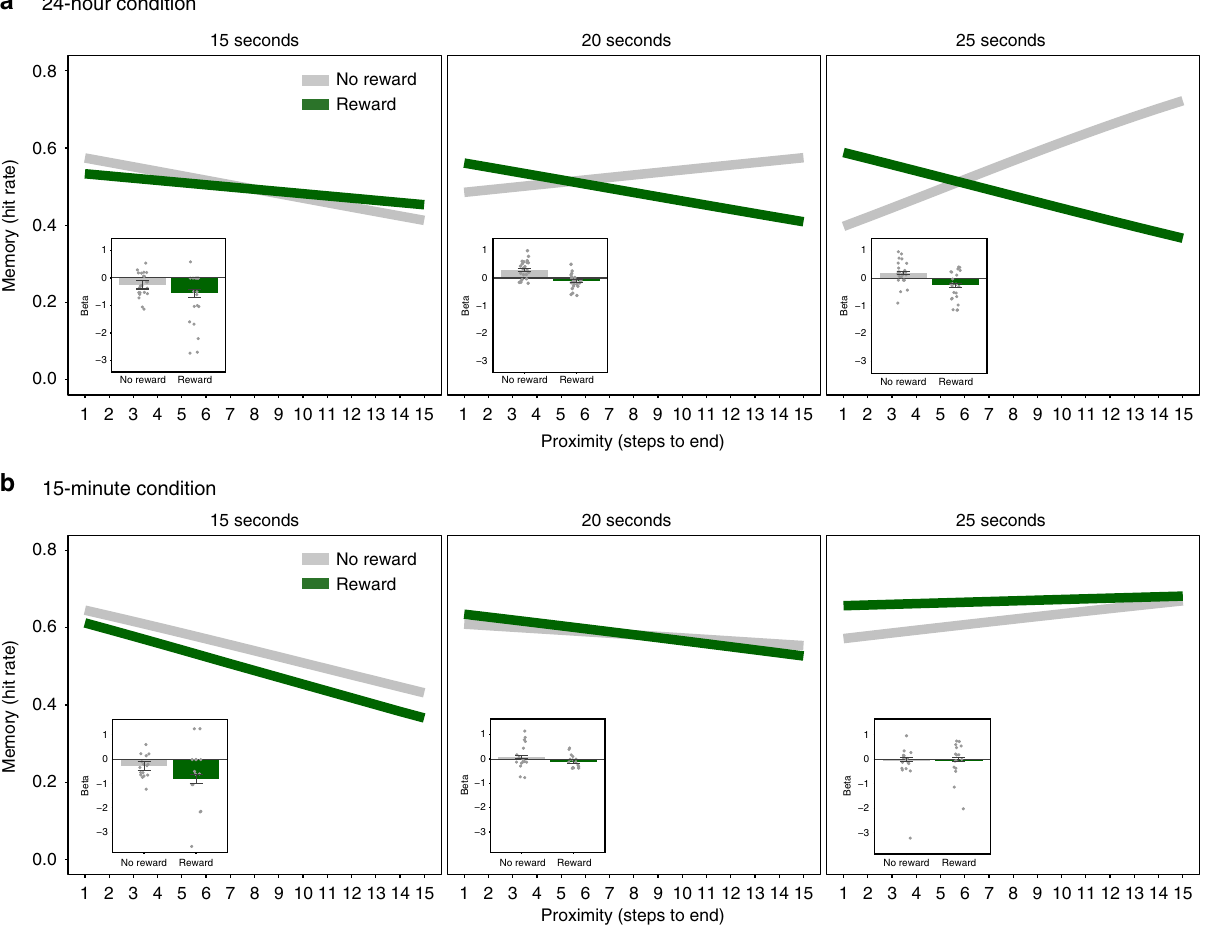
Fig. 3 Reward proximity effect increases with longer post-encoding rest. (Experiment 1). a In the 24-hour condition ( n = 23), we found that the duration of the rest break following each maze modulated the reward proximity effect, such that the interaction was stronger if the rest break following the maze was longer. b In the 15-minute condition ( n = 21), we did not fi nd an effect of the duration of the rest break modulating the reward by proximity interaction. The direct comparison of the 24-hour and 15-minute conditions showed a signi fi cant interaction (see Supplementary Table 1b for post hoc tests). The insets depict the beta coef fi cients for the reward and no-reward conditions. The error bars represent the standard error of the reward × proximity interaction, and the dot plot overlay shows the reward and no-reward betas across